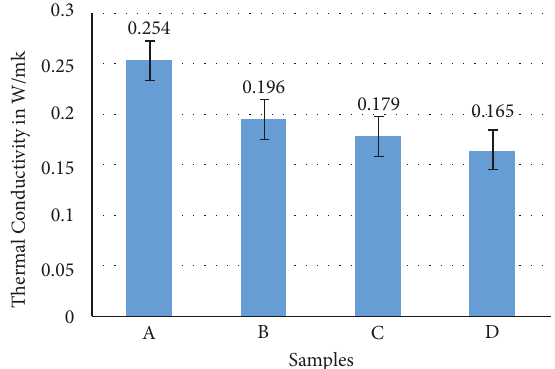
Figure 3: Thermal conductivity of basalt fiber